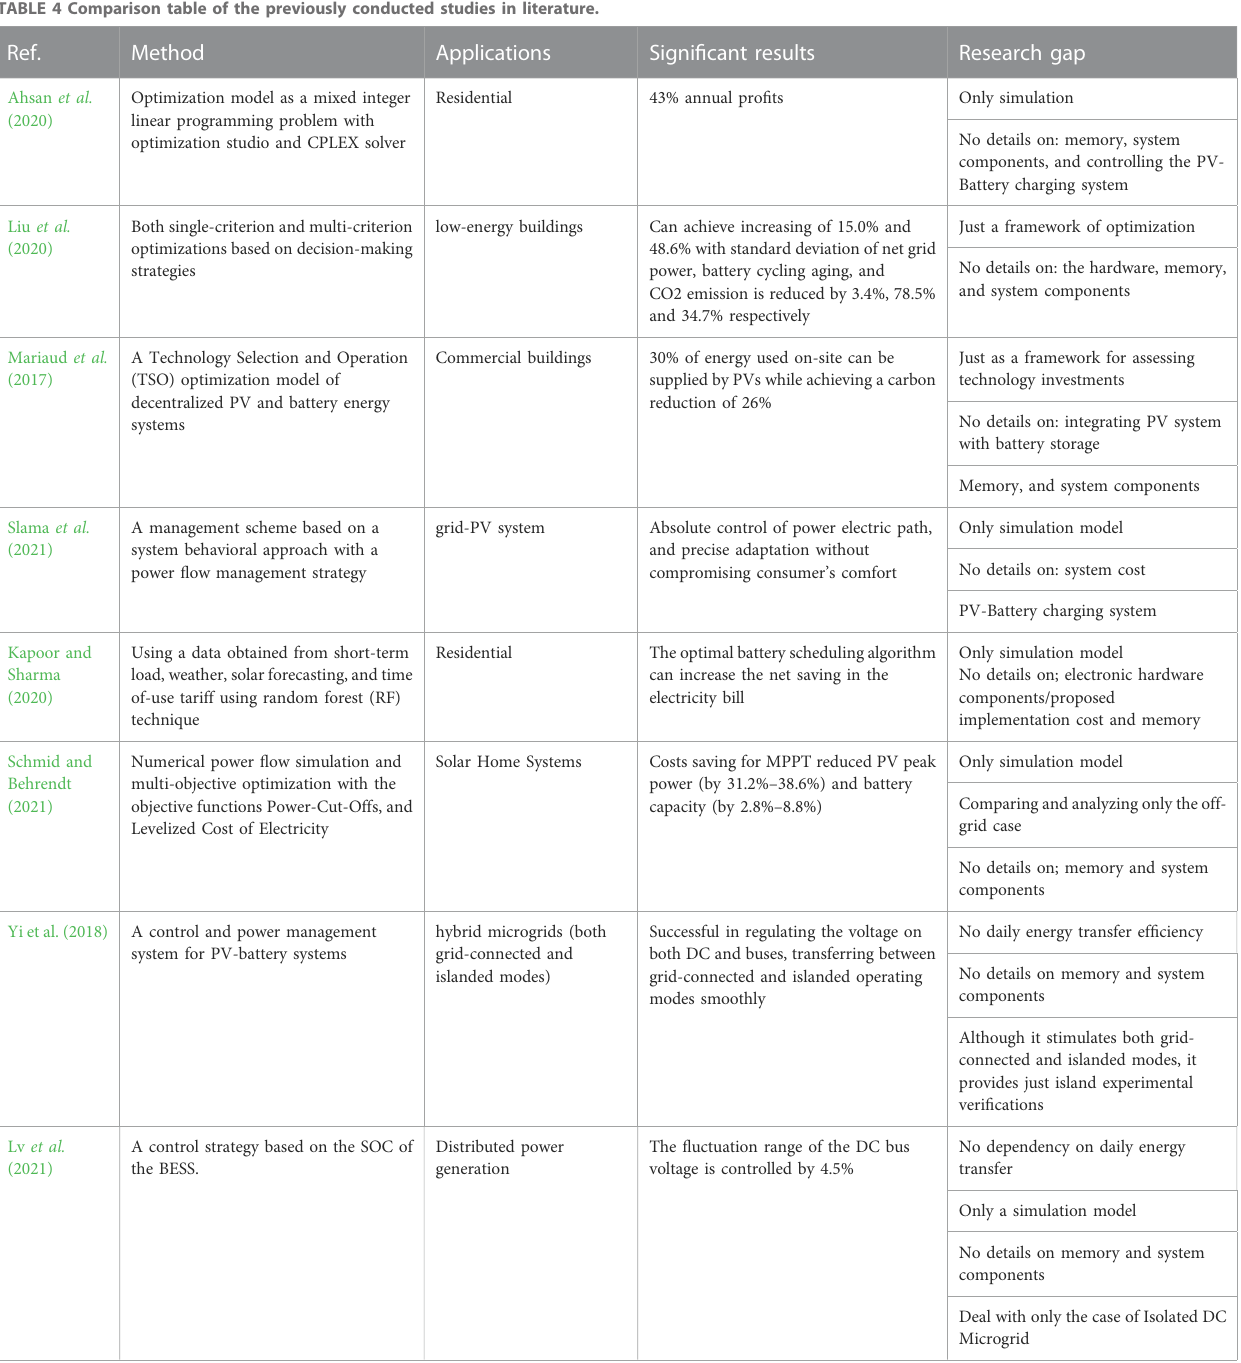
TABLE 4 Comparison table of the previously conducted studies in literature.